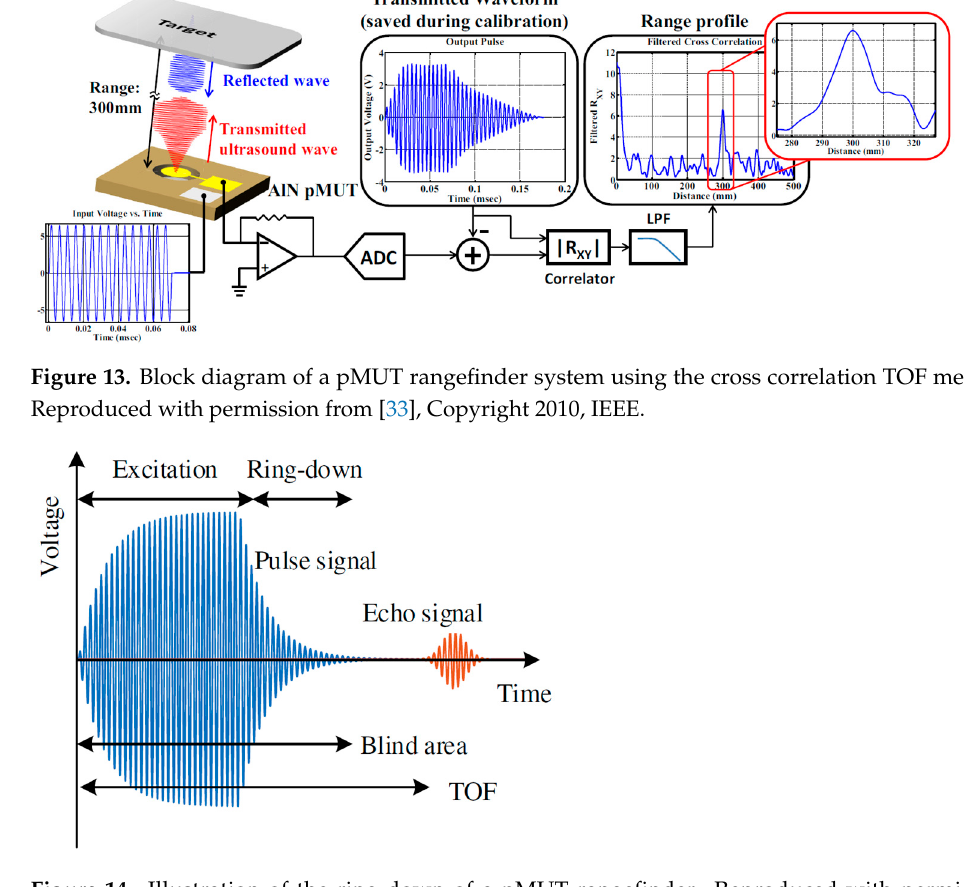
Figure 14. Illustration of the ring down of a pMUT rangefinder. Reproduced with permission from [107], Copyright 2021, MDPI